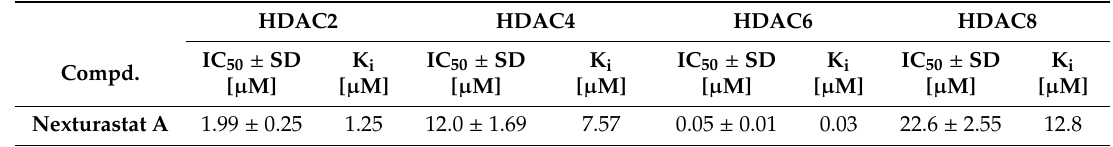
Table 5. IC 50 and inhibitory constants (K i ) of nexturastat A on HDAC2, 4, 6, and